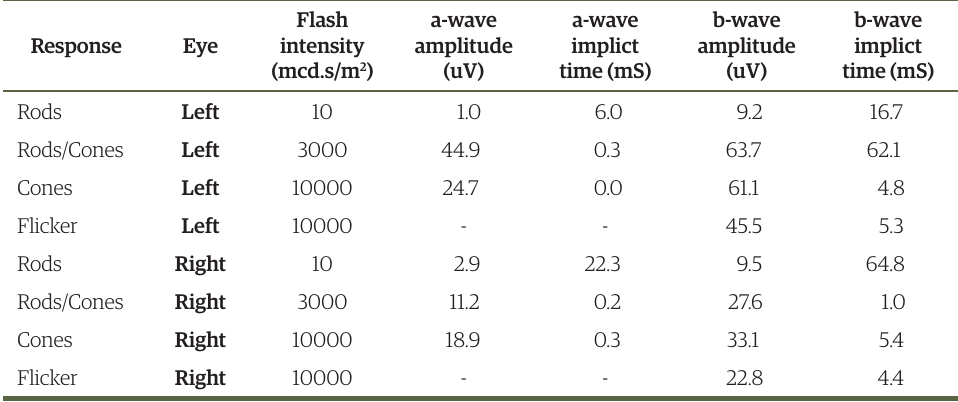
Table 2. Electroretinographic response of a 5-month-old female horse (case 1) of the breed Mangalarga Marchador presenting with congenital night blindness.